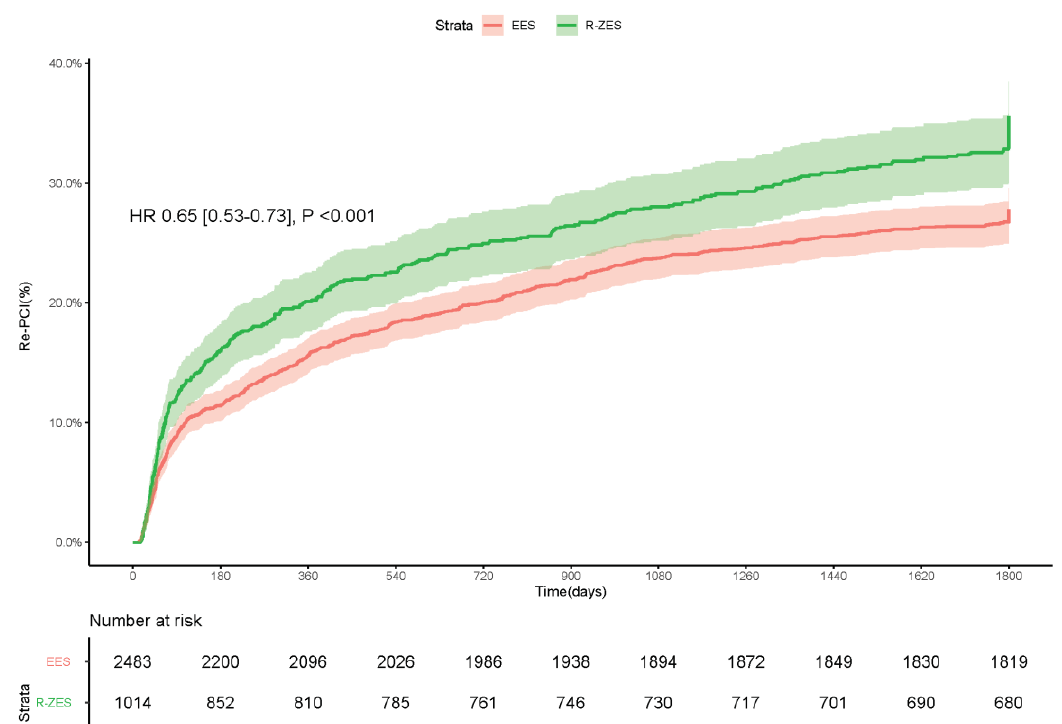
Figure 5. Kaplan–Meier graph of the cumulative incidence of repeat PCI. No significant difference was found in stroke risk between EES and R-ZES: 4.7% vs. 5.4%: HR [95%CI] = 0.84 [0.61–1.17], p =